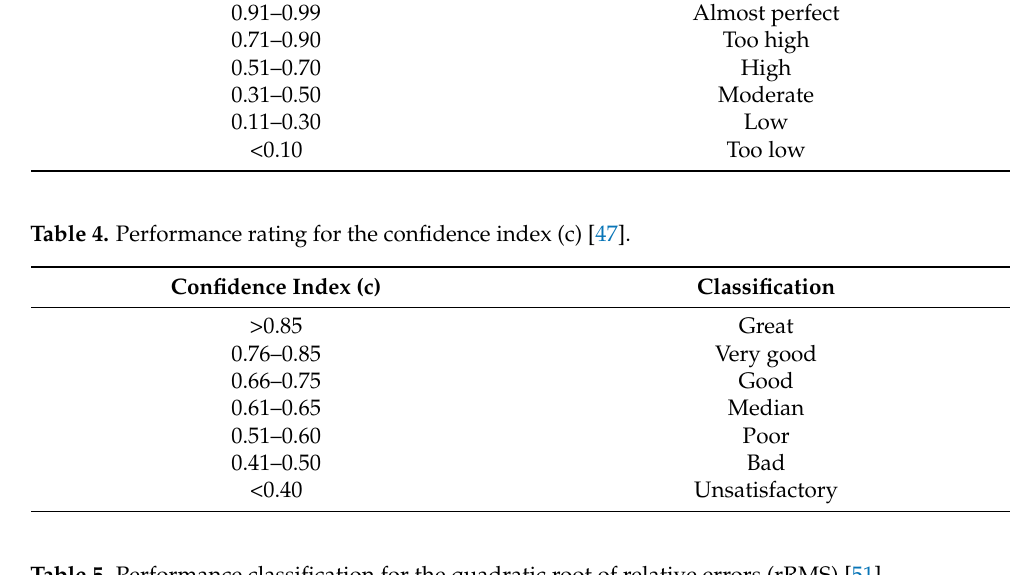
Table 5. Performance classification for the quadratic root of relative errors (rRMS) [51].